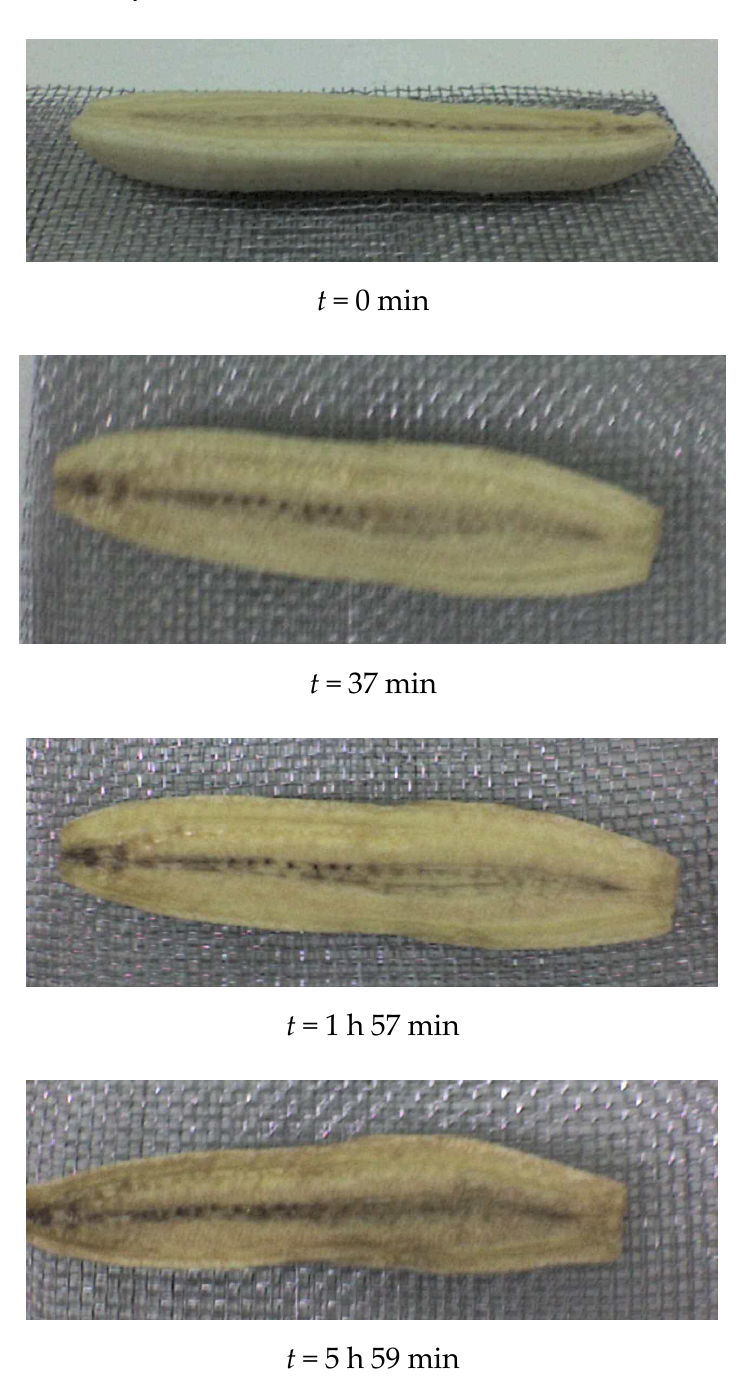
ff erent moments of drying (T = 60 ◦ Figure 8. Banana slices at different moments of drying (T = 60 °C). Figure 8. Banana slices at di